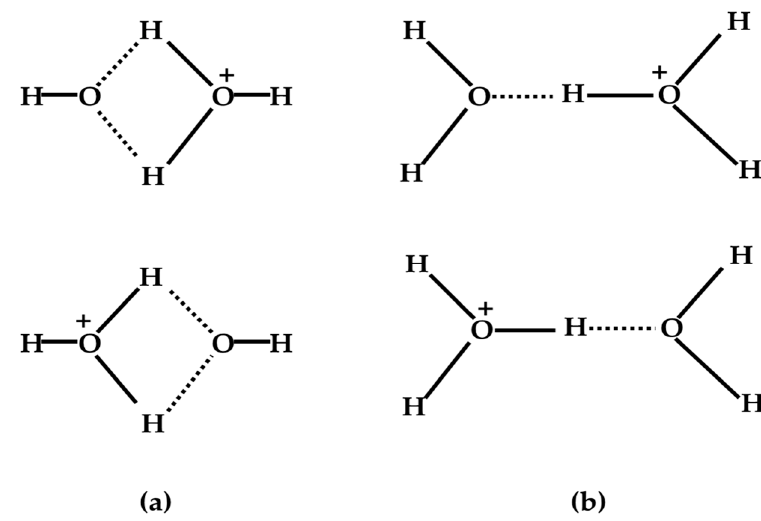
Figure 2. Proposed resonance structures for the ( a ) (H 4 O 2 ) +• and ( b ) (H 5 O 2 ) + ions. Figure adapted from [19] with permission. Copyright 1970 American Institute of Physics.